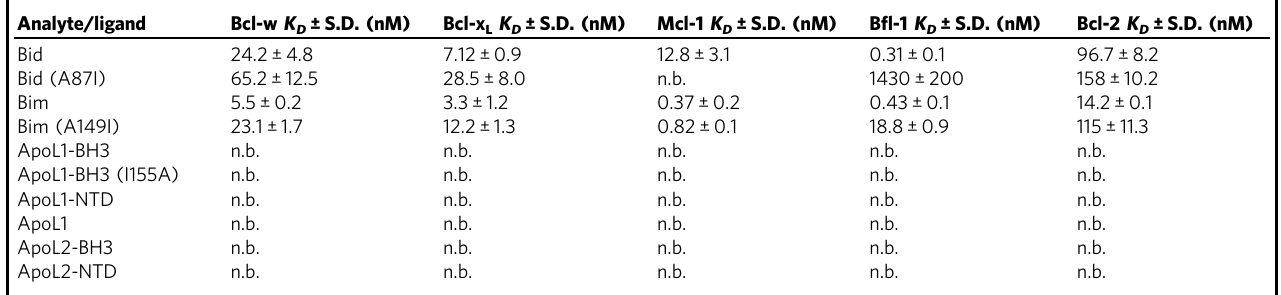
Kinetic constants were determined by surface plasmon resonance and represent the average±S.D. of at least three independent experiments. No binding (n.b.) was detected up to 3 µ M fi nal